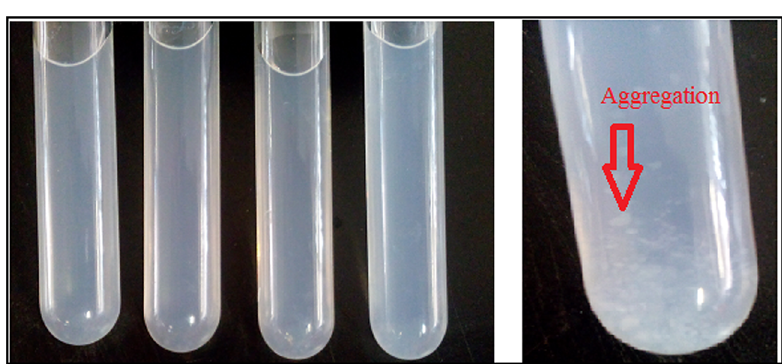
Fig. 5 Long time stability